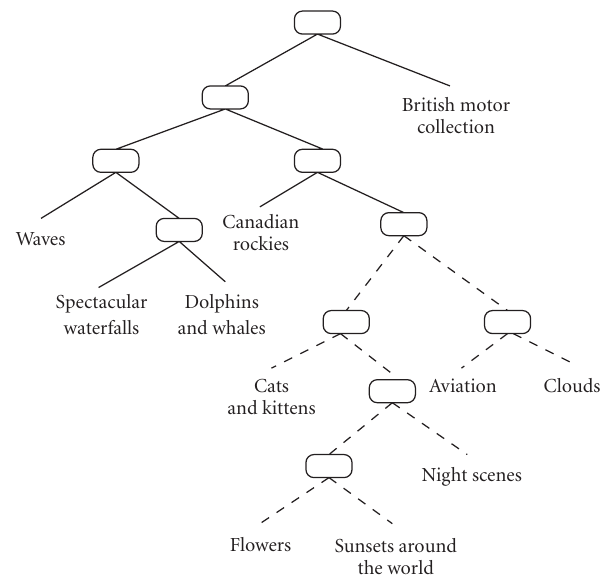
Figure 2: The classification tree obtained from the first training set using correlograms. The dotted lines indicate the trimmed